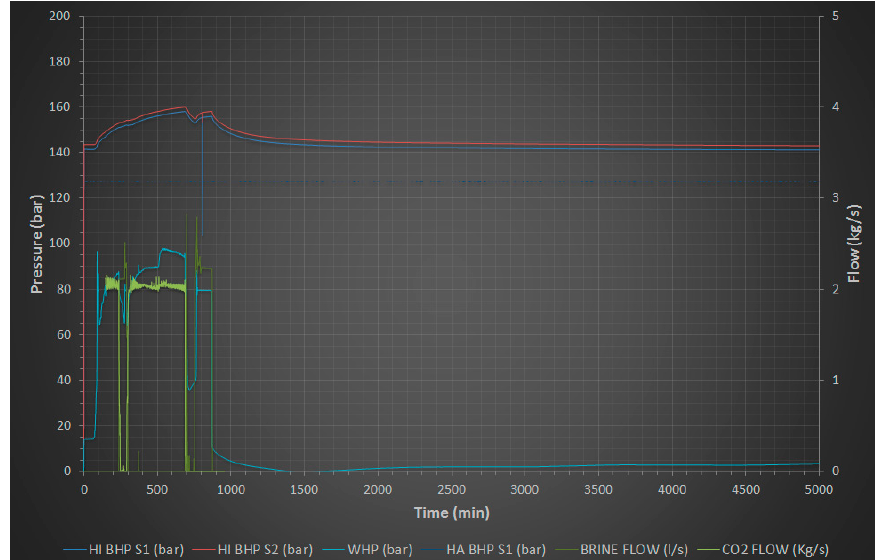
Figure 3. The evolution of the operating parameters of the eight-hour CO 2 injection in the flow control mode (2 kg/s). The bottom hole pressure ( BHP ) data from the two sensors located in the open hole of the HI well ( HI BHP S1/S2 ), well-head pressure ( WHP ) in the injection well, BHP from the sensor located in the seal of HA well ( HA BHP S1 ) and the flow rate of brine and CO 2